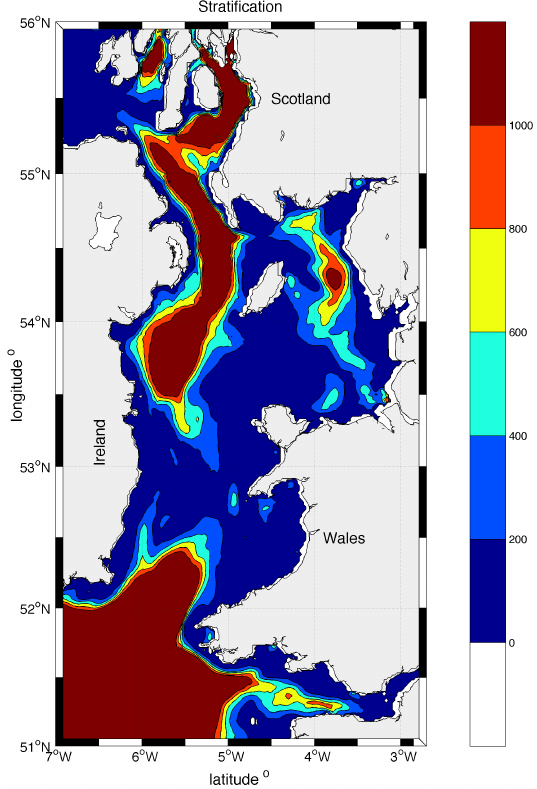
Fig. 8. Non-dimensional stratification of the Irish Sea as defined by the non-dimensional buoyancy